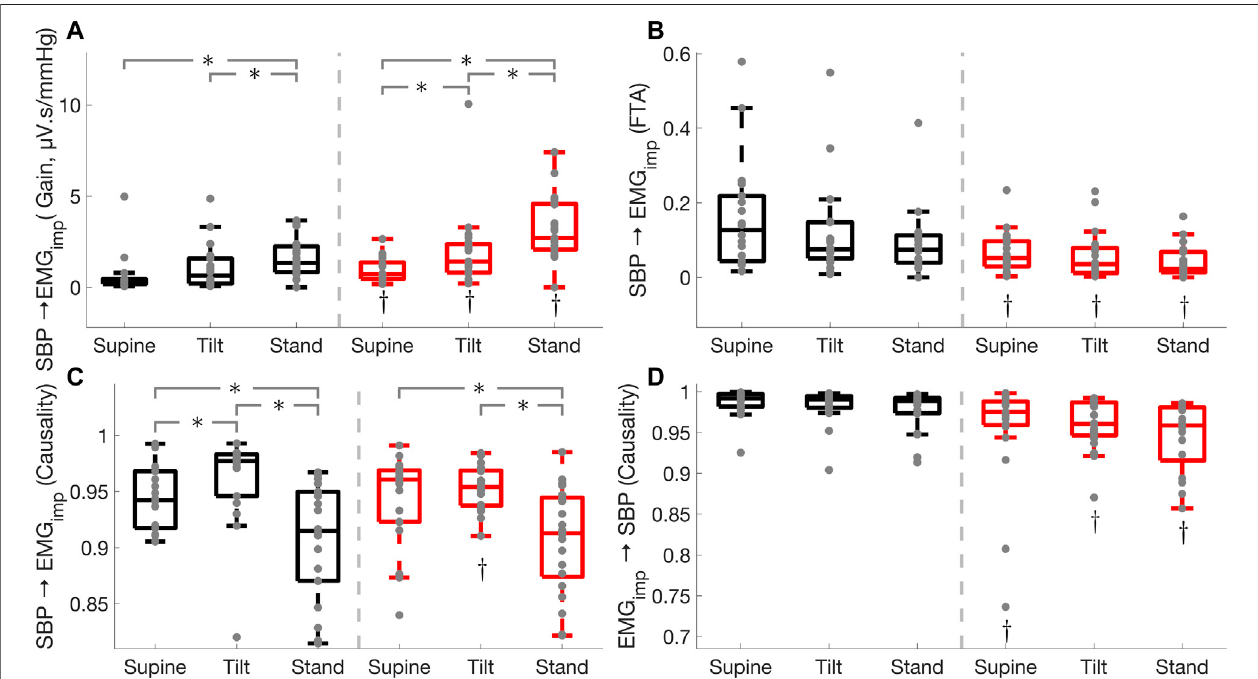
FIGURE 6| Effect of Parkinson ’ s disease on cardio-posturalcoupling (SBP → EMG imp ) , and muscle-pump ( EMG imp → SBP ) . Cardio-postural coupling gain (A) , cardio-postural coupling fraction time active (B) , cardio-postural coupling causality (C) , and muscle-pump (D) . * illustrates a signi fi cance difference for multiple comparison (post-hoc analysis with Bonferroni adjustment) between supine, tilt, and standing in Parkinson ’ s disease patients (red) and healthy controls (black), while † represents a signi fi cant difference (Wilcoxon rank sum test) between Parkinson ’ s disease patients and healthy controls.